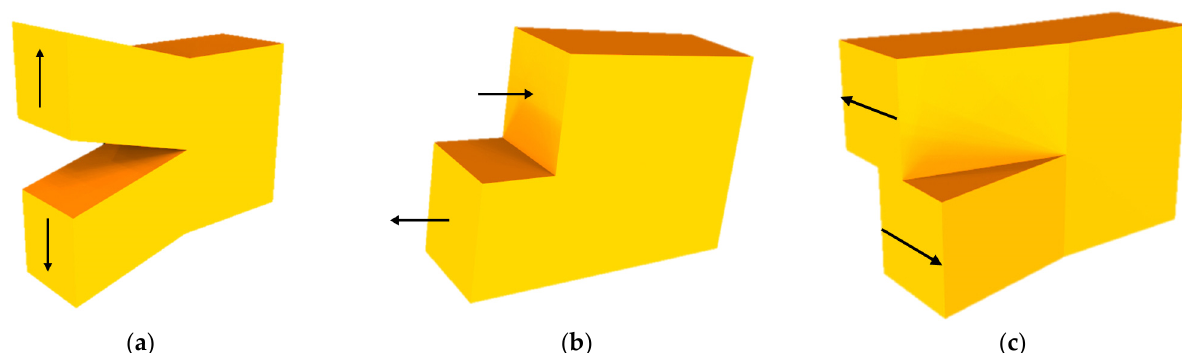
Figure 4. Basic fracture modes. ( a ) mode I (opening); ( b ) mode II (shearing); ( c ) mode III (tearing).